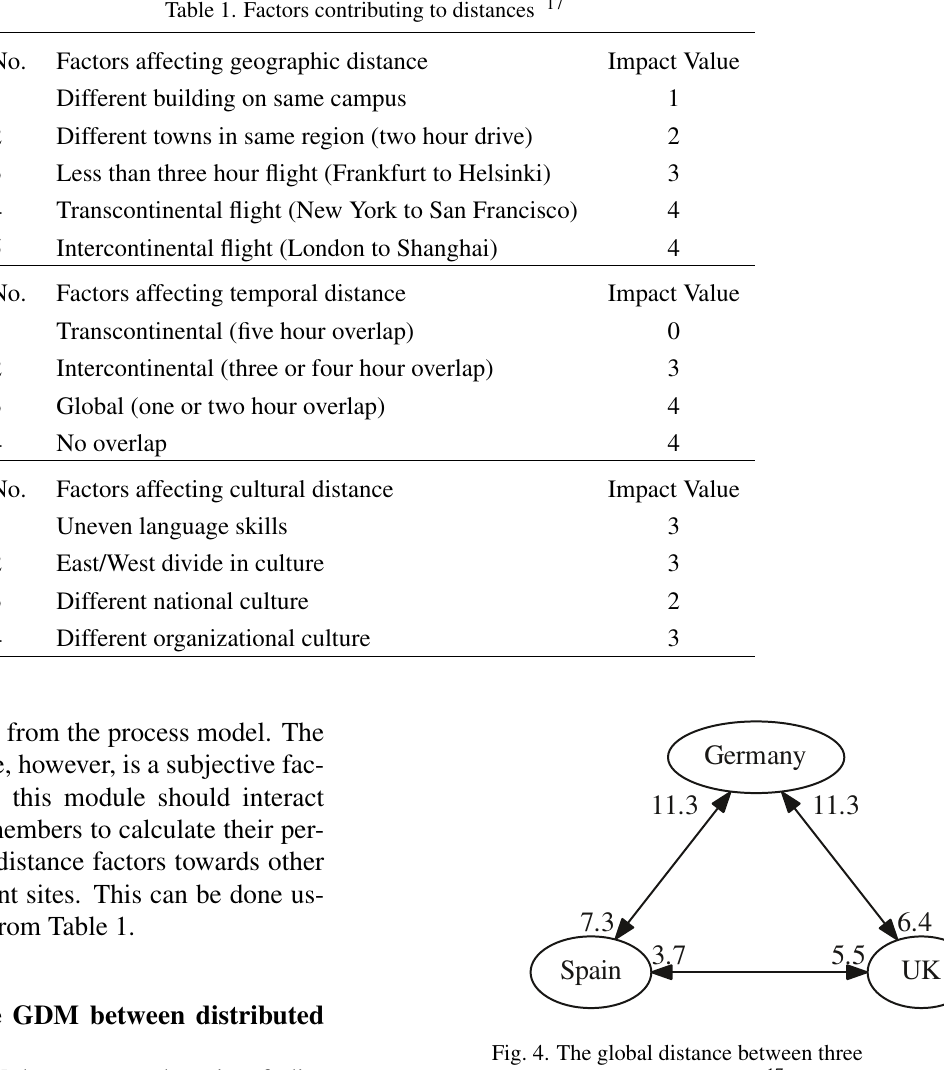
Table 1. Factors contributing to distances 17